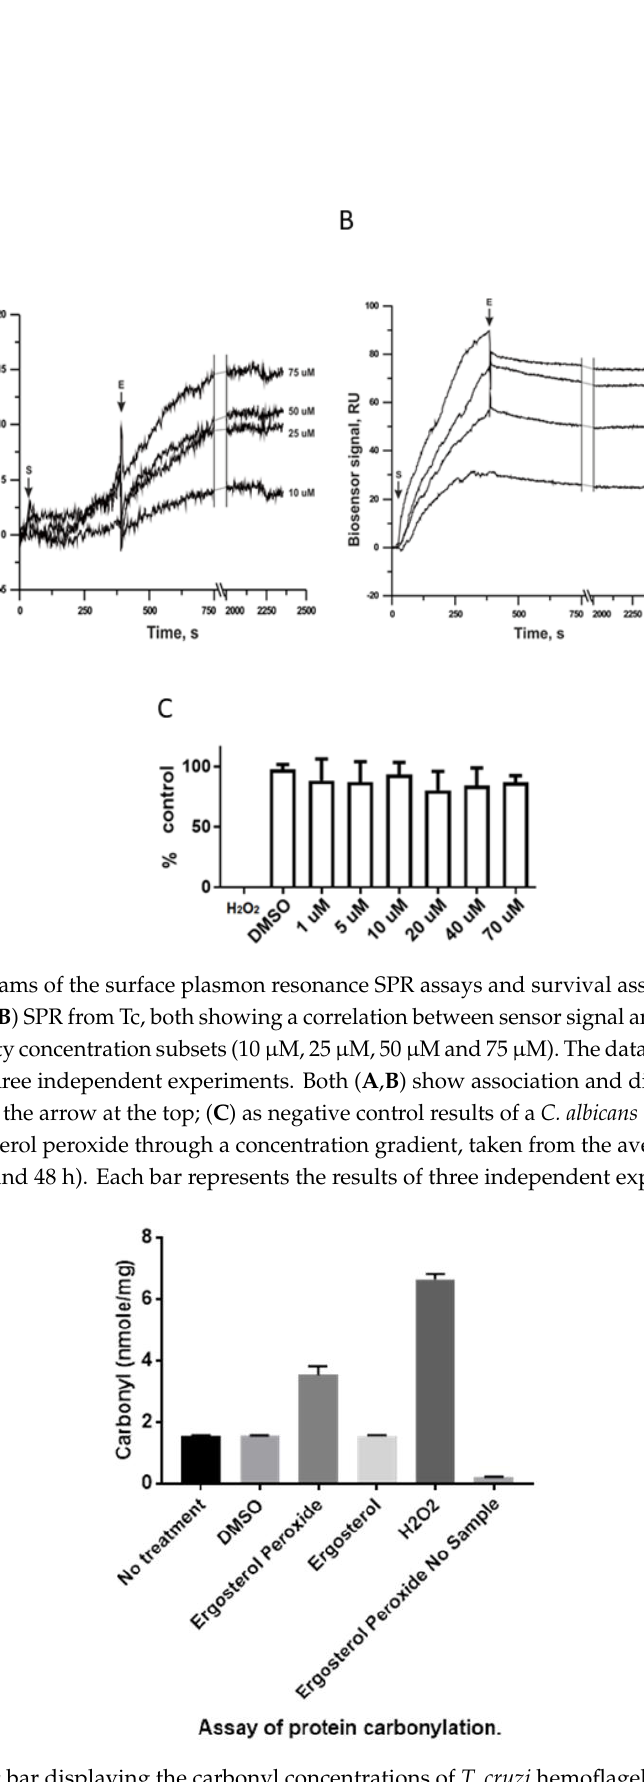
Figure 4. Graphic bar displaying the carbonyl concentrations of T. cruzi hemoflagellates after various treatments. Lane 1, no treatment; lane 2 (less than 1% dimethyl sulfoxide); lane 3, ergosterol